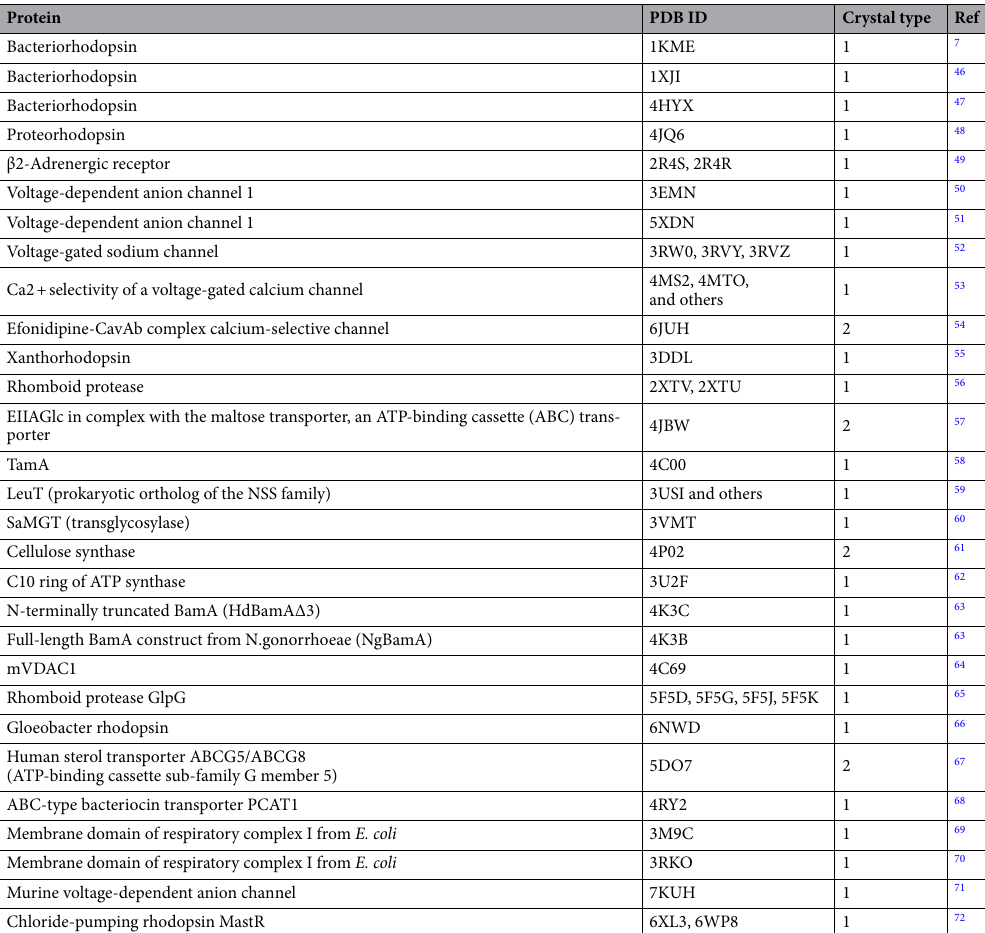
Table 1. The list of the membrane proteins whose structure was resolved by X-ray crystallography using bicellar systems. The additional information such as bicelle formulation, temperature conditions, buffer composition and parameters of a soluble part of proteins is provided in Supplementary Table